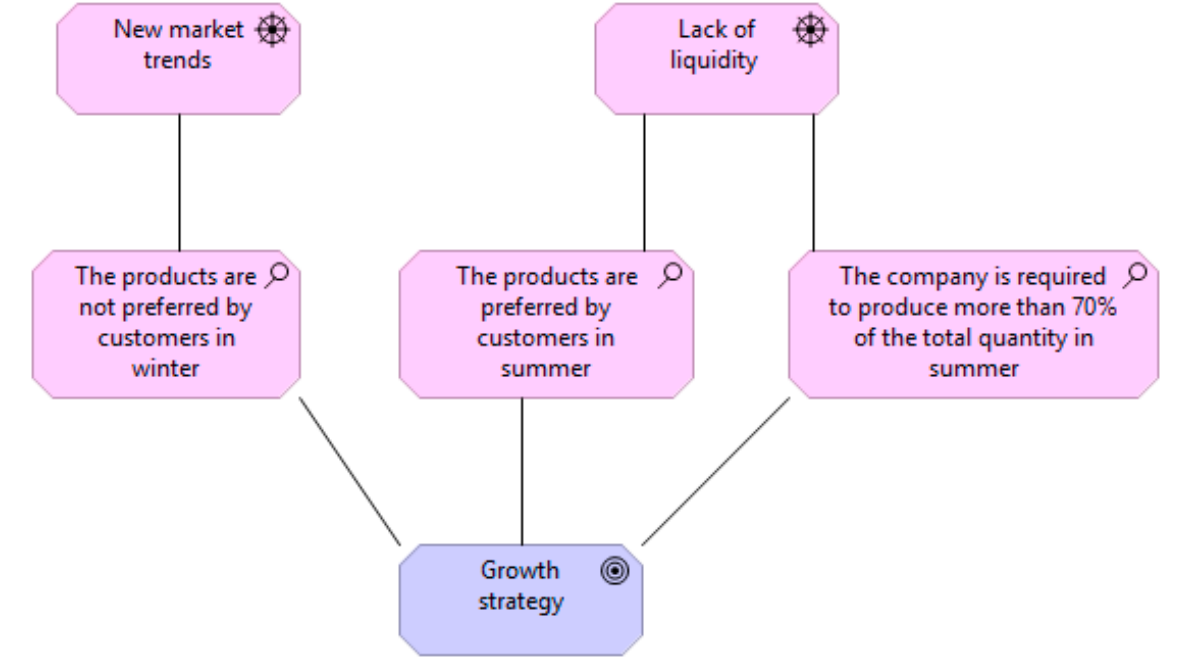
Figure 9. Formulation of the business strategy, based on drivers and assessments.